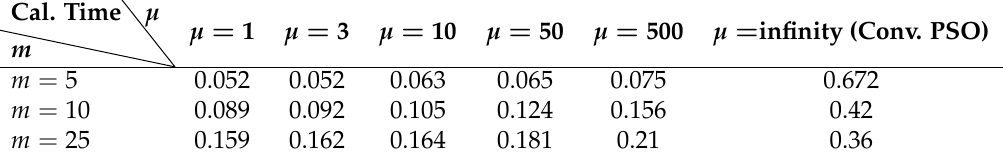
Table 3. Average calculating time with different µ and m where w = 0.8, p = 8, q = 2, N = 100, SNR = 5 dB, RMSE =